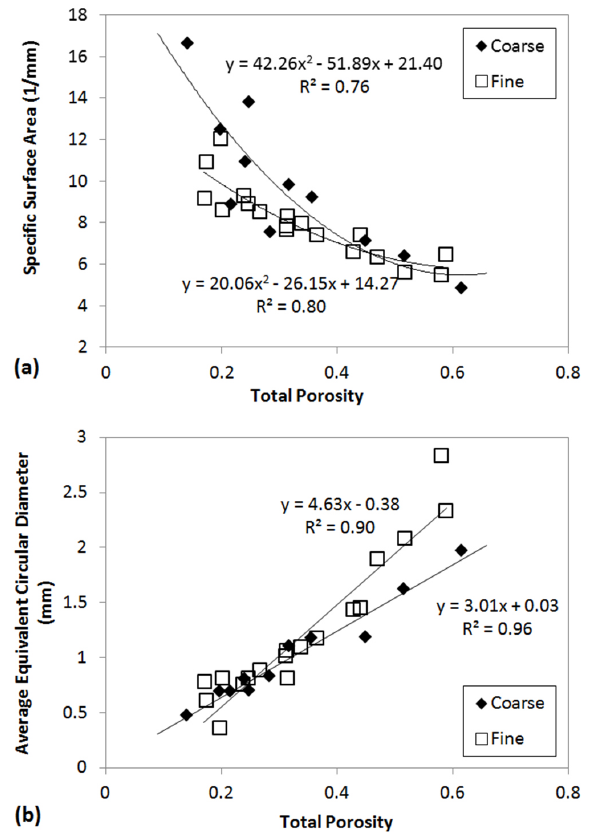
Fig. 7. (a) Specific surface area vs. total porosity; (b) Average equivalent circular diameter vs. total